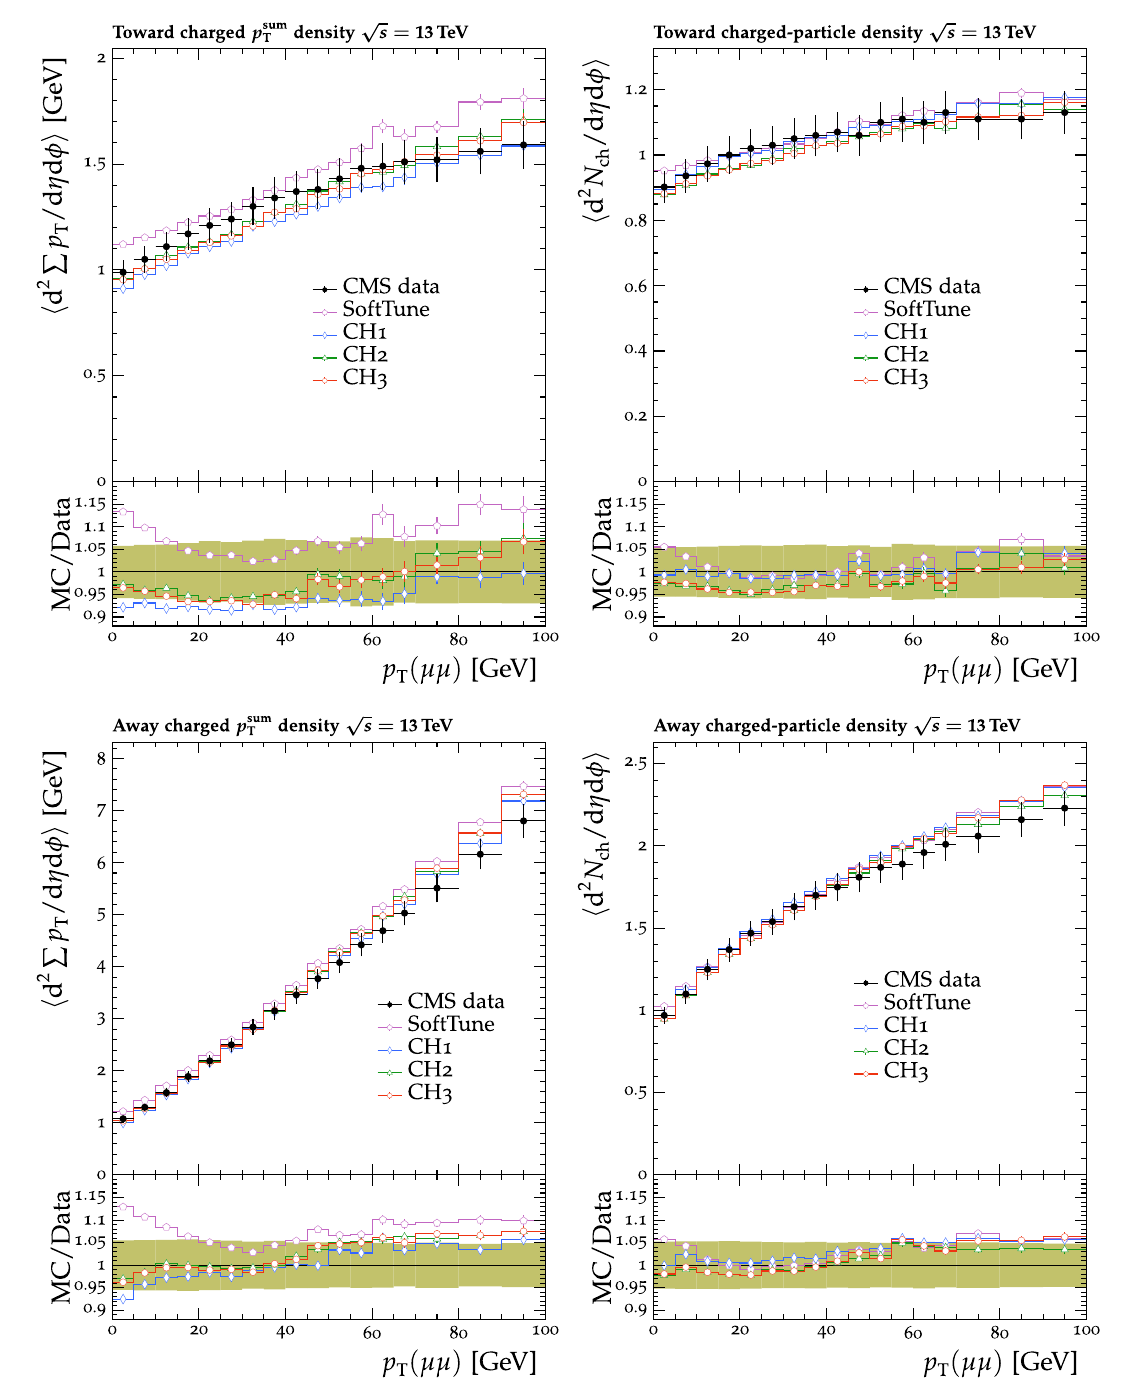
Fig. 17 The p sum (left) and N ch (right) density distributions in the T toward (upper), and away (lower) regions, as a function of the p T of the two muons, p T (μμ) [45]. The toward and away regions are defined with respect to p T (μμ) , where the two muons are required to have an invariant mass close the the mass of the Zboson. CMS Zboson data